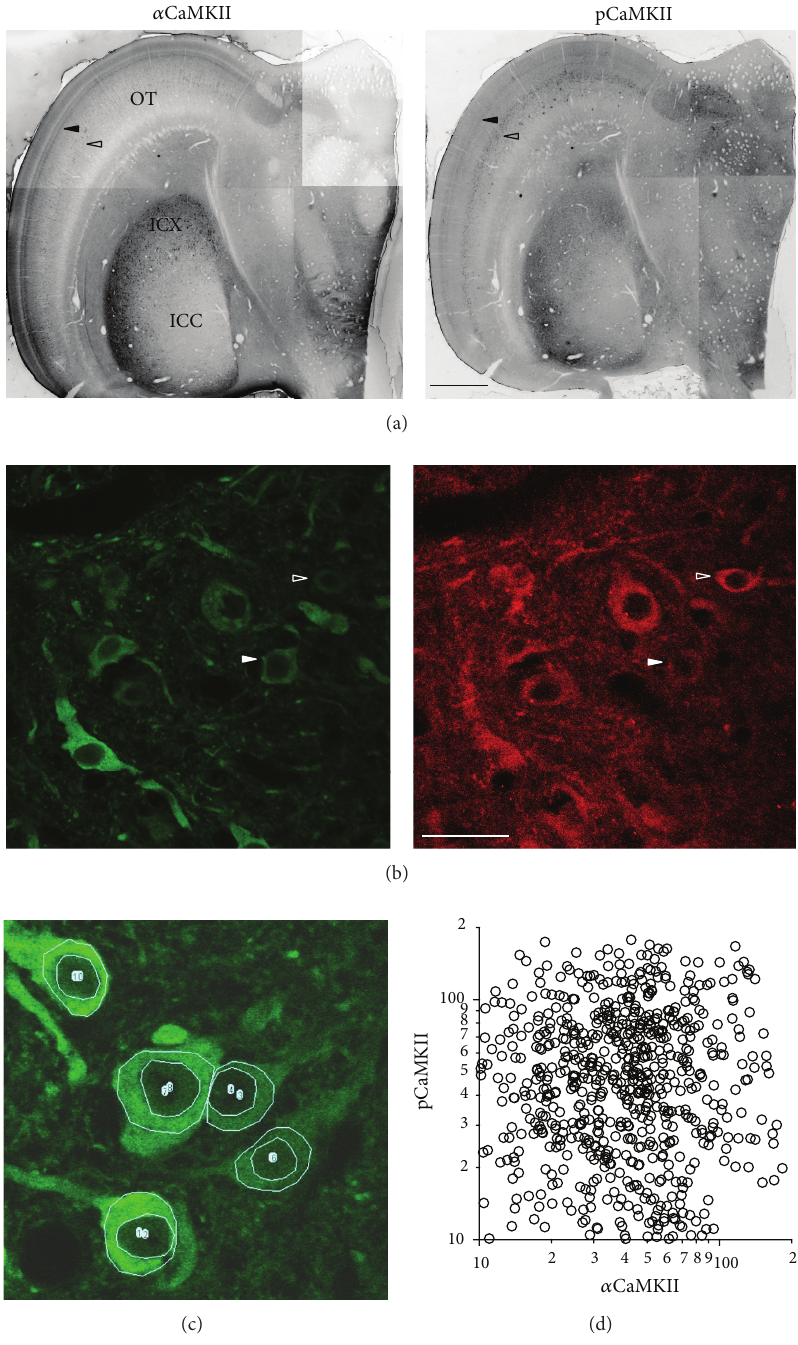
Figure 3: Immunohistochemistry. (a) Regional distribution of 𝛼 CaMKII (left) and pCaMKII (right). Montages were constructed from low magnification images of a single horizontal section (40 𝜇 m) through the L midbrain of an adult owl. The red and green color channels were converted to grayscale for viewing only. Within the inferior colliculus, both proteins were most strongly expressed in ICX, the site of plasticity. Within the optic tectum, 𝛼 CaMKII was most strongly expressed in layers 8 and 10 (solid arrowhead), whereas pCaMKII was most strongly expressed in layers 12/13 (hollow arrowhead). (b) Subcellular distribution of 𝛼 CaMKII (left) and pCaMKII (right) in ICX. Shown is a single optical section from a high magnification confocal stack. Both proteins were localized to the same population of cells and both expressed in the perikarya. The relative intensity of staining varied from cell to cell (compare open and hollow arrowheads). (c) Perinuclear ROIs were manually traced for every neuron in the image field ( 𝑛 = 5 neurons in this example); nuclear staining mostly occurred in small punctae (one or two per nucleus in this example) and was measured separately. (d) Signal intensities for each perinuclear ROI in adult owls (6 owls, 804 cells). There was no correlation between 𝛼 CaMKII and pCaMKII signals ( 𝑅 = −0.014 , 𝑃 = 0.78